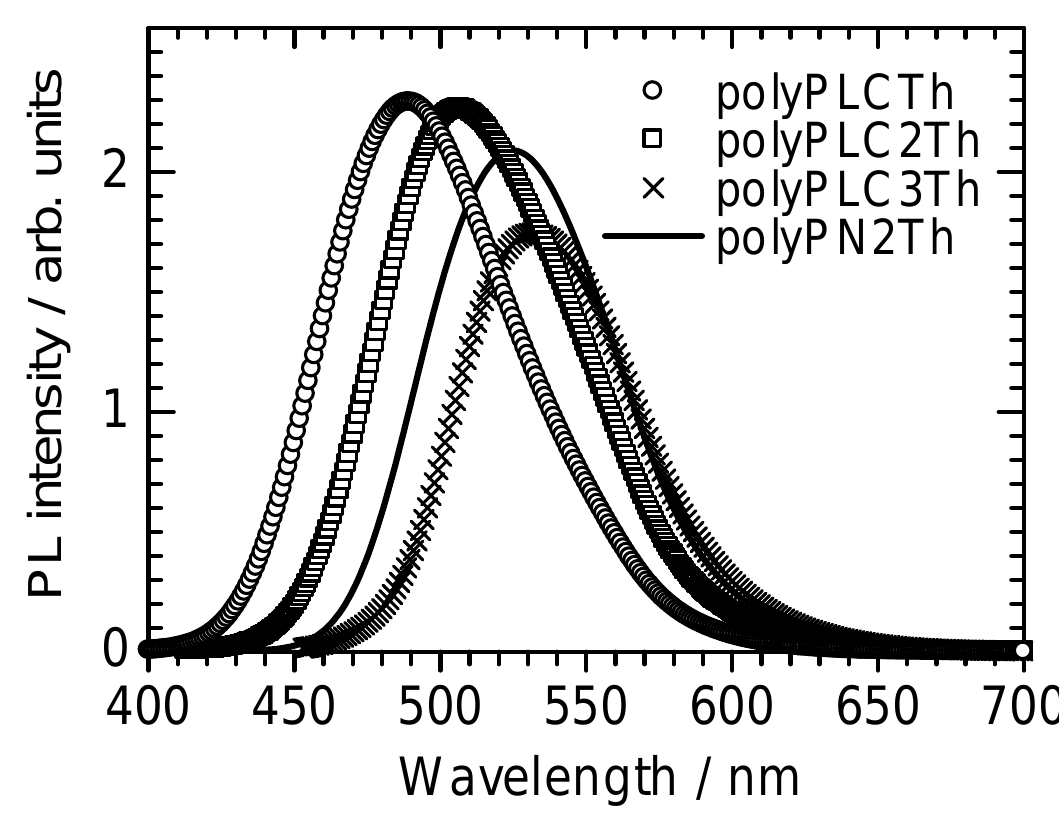
Figure 5. Photoluminescence spectra of the